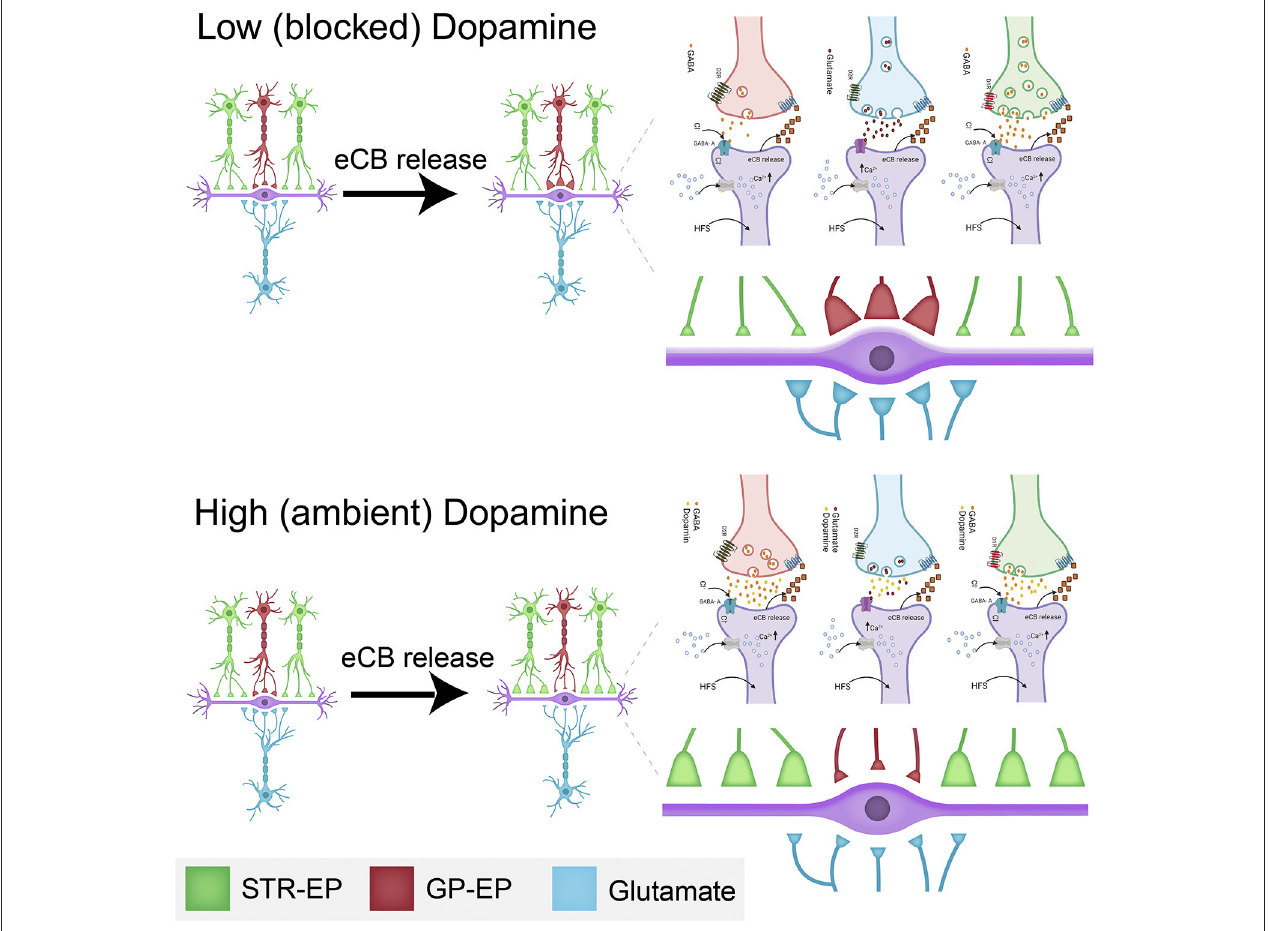
FIGURE 10 | Schematic drawing of the dopamine-eCB induced synaptic dynamics in the EP. The top drawing displays the changes schematically to synaptic strength at low (or blocked) dopamine levels. The bottom illustration shows the changes schematically to synaptic strength at high (or ambient) dopamine levels. The changes to synaptic strength are depicted by the relative changes to the size of individual synaptic terminals in the figure and enlarged on the right. Some of the biochemical mechanisms involved in plastic changes described in this manuscript are shown in each panel. These detailed drawings were made with